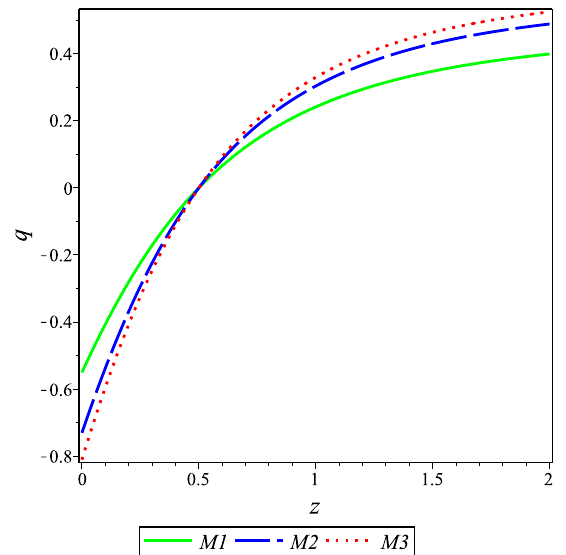
Figure 2. The deceleration parameter, q (38), versus redshift, z , for three observational models M1, M2, and M3. See text for